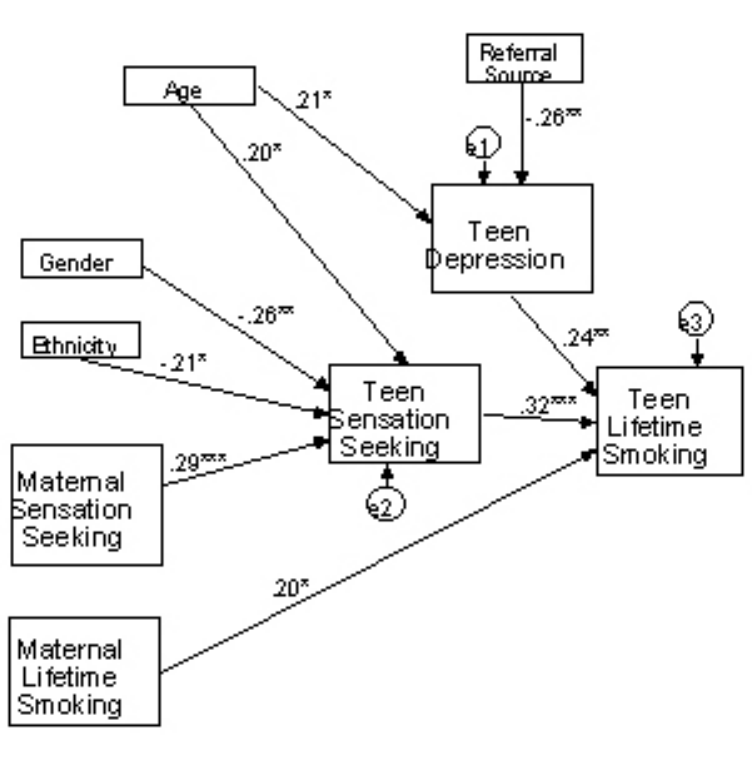
FIGURE 1. Trimmed Full Effects Model (standardized coefficients). Coefficients indicate when the predictor variable increases 1 standard deviation, the dependent variable increases (e.g., by 0.29 standard deviations); * p < 0.05, ** p < 0.01, *** p < 0.001; all coefficients are standardized: Gender, 0 = male, 1 = female; Race, 0 = white, 1 = black or other; Referral source: 0 = Psychiatry, 1